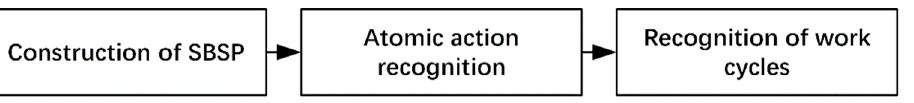
Figure 2. The framework of the proposed method based on stretching-bending sequential pattern (SBSP).